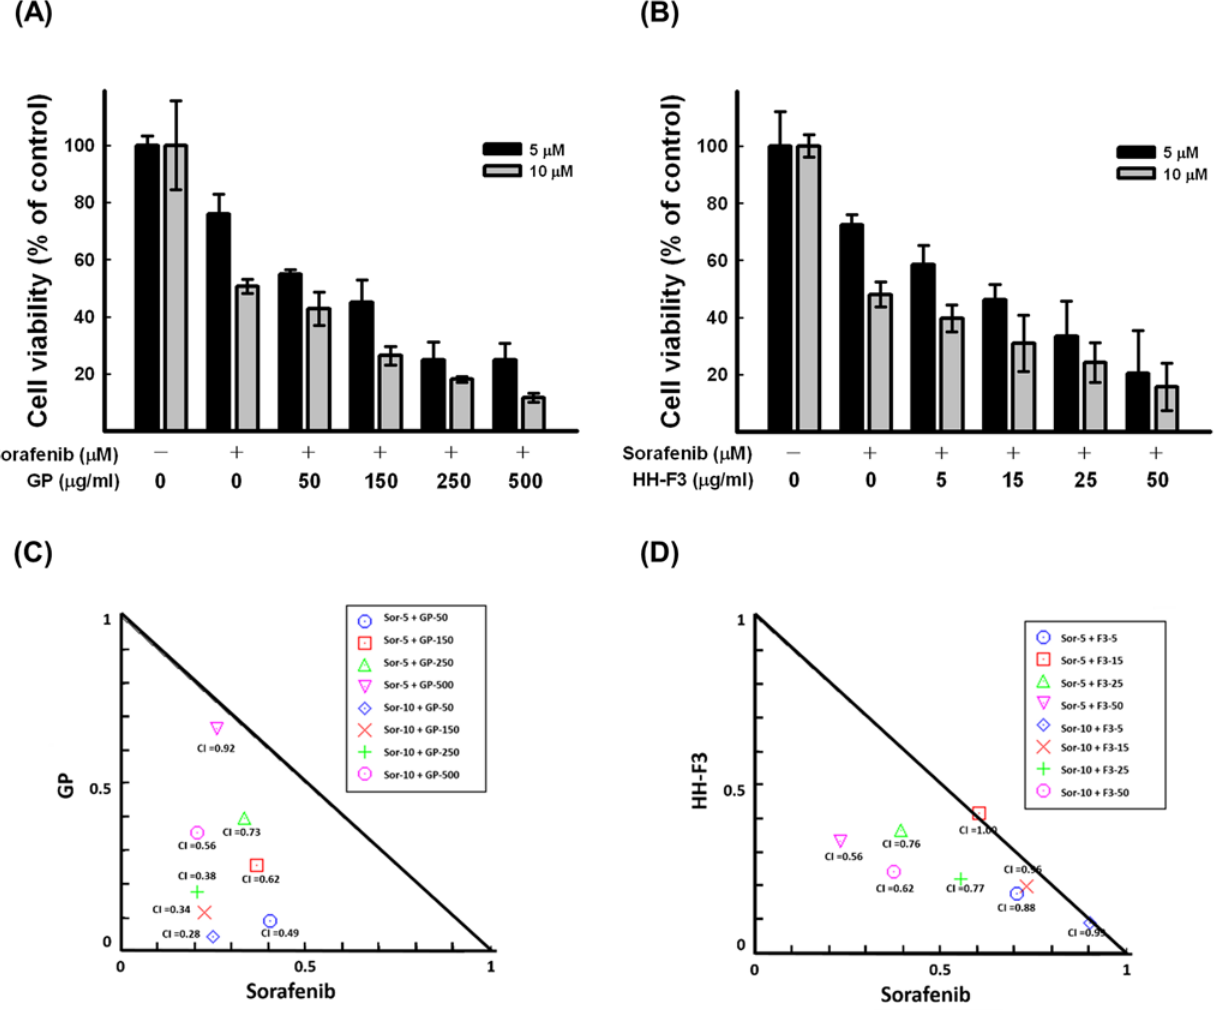
Fig 6. Synergistic effect of the combination of GP extracts/HH-F3 and sorafenib on the viability of Huh7 cells. (A, B) Huh7 cells were treated with various concentrations of 30% DMSO GP extracts/ HH-F3 in the presence or absence of sorafenib (5 μ M and 10 μ M). Cell viability was determined with the SRB assay. Data are expressed as the mean ± standard deviation (SD) of three independent experiments. (C, D) Isobologram analysis demonstrates the synergistic interaction between sorafenib and various concentrations of GP/HH-F3 in Huh7 cells at 72